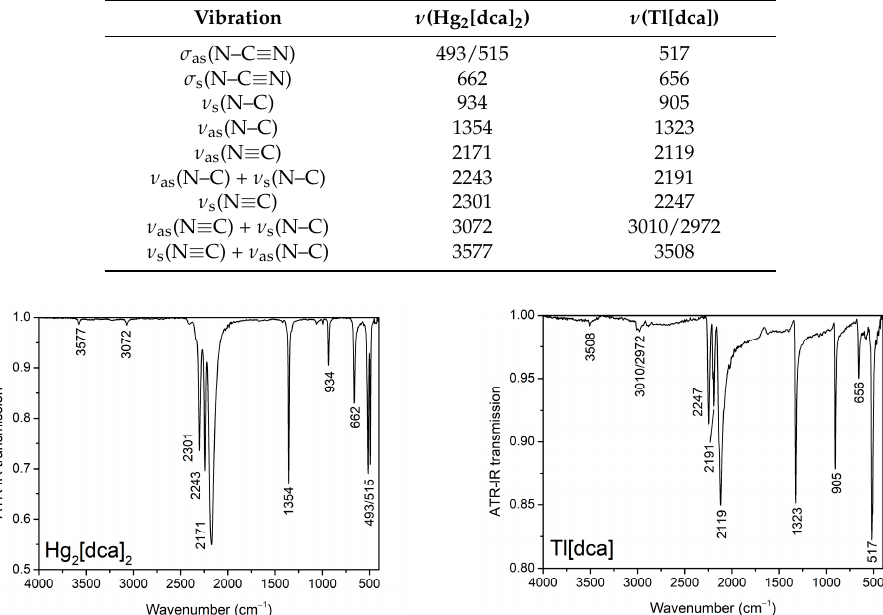
Figure 4. Infrared spectra of Hg 2 [dca] 2 ( left ) and Tl[dca] ( right ).